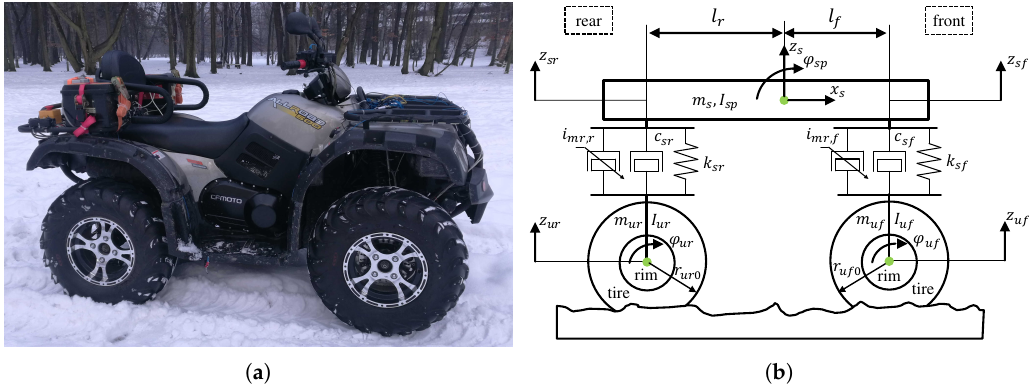
Figure 1. The experimental all terrain vehicle with magnetorheological (MR) dampers: ( a ) actual vehicle, ( b ) graphical representation of the implemented half-car model with 7